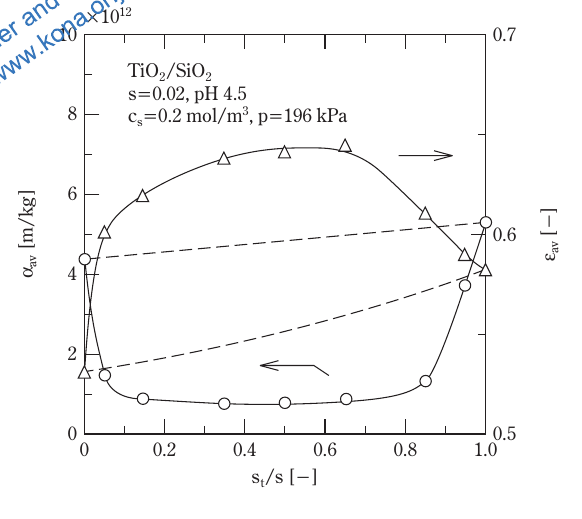
Fig. 19 Effect of mixing ratio of proteins on average specific fil- tration resistance and average porosity in ultrafiltration of binary protein mixtures at pH